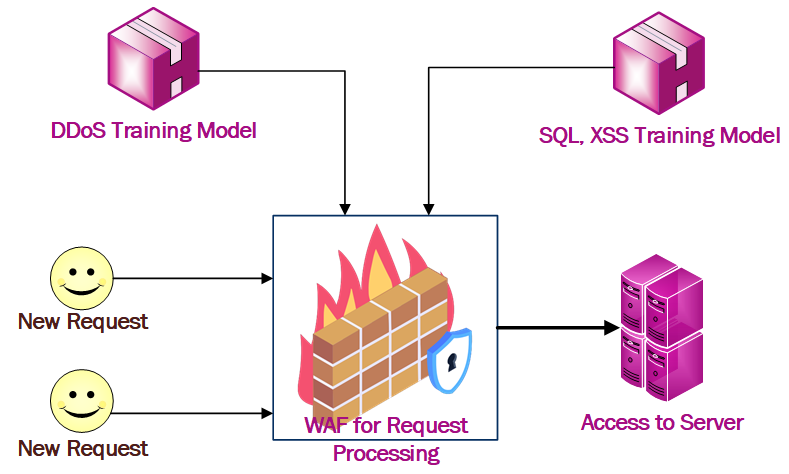
Figure 4. Model development